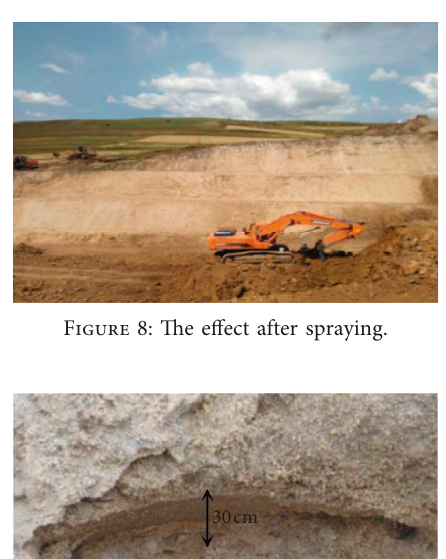
Figure 6: Stress changes with strain: modulus 3.3.